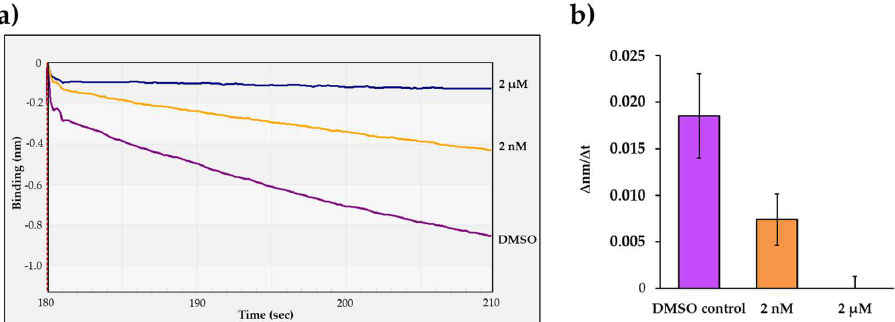
Figure 5. Determination of the inhibitory effect of atazanavir on HIV-1 PR activity. ( a ) Representative sensograms of the enzyme reactions performed by using atazanavir in 2 nM and 2 µ M final concentration. ( b ) Comparison of obtained initial ∆ nm/ ∆ t values which were determined based on the slopes (2–10 s after initiation of the reaction). Error bars represent SD (n = 2). Representative signal curves are shown for all steps of the assay in Figure